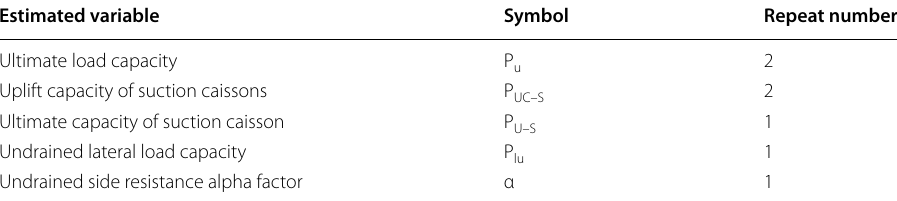
Table 8 GP estimated